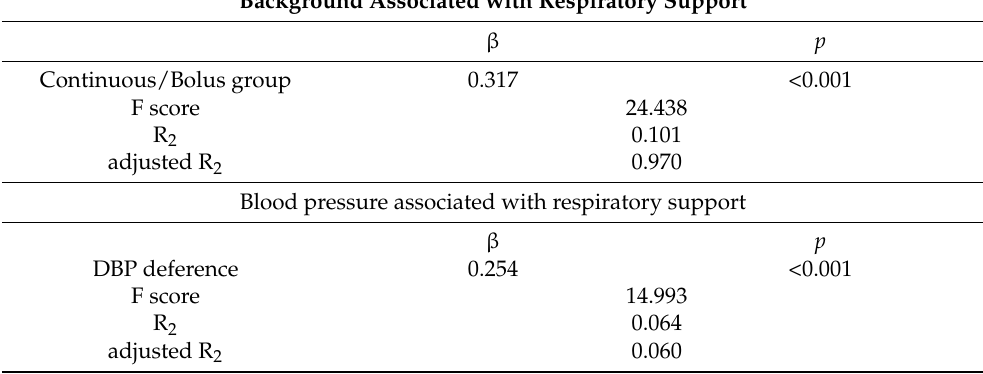
Table 4. The results of the regression analysis conducted to evaluate the association between the need for respiratory support and maternal background factors and parameters related to blood pressure changes after spinal